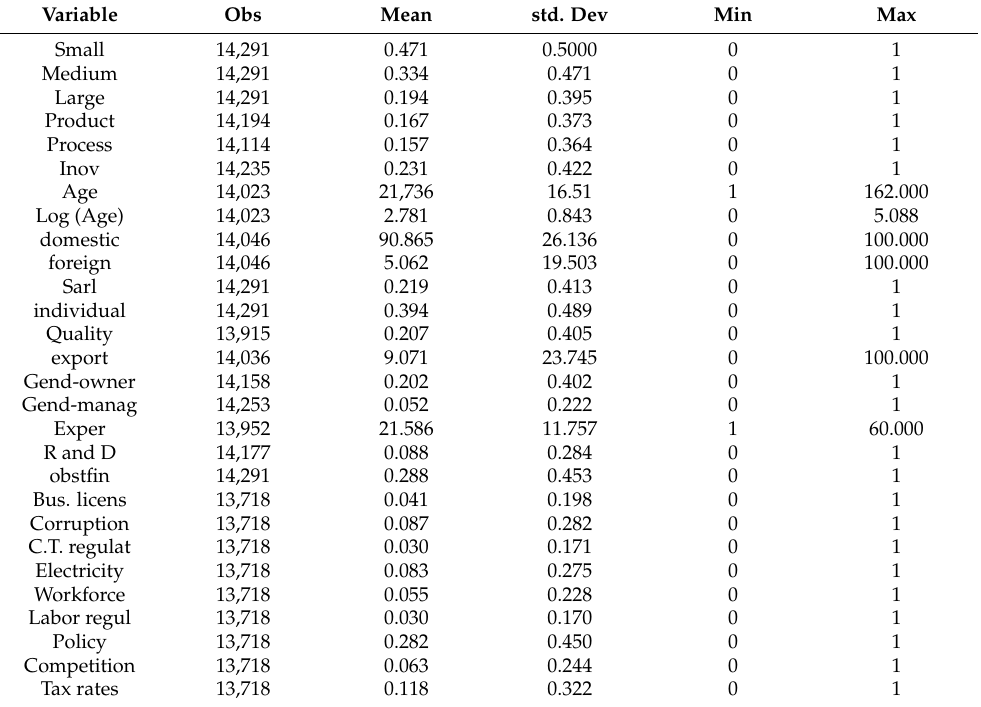
Table 3. Descriptive